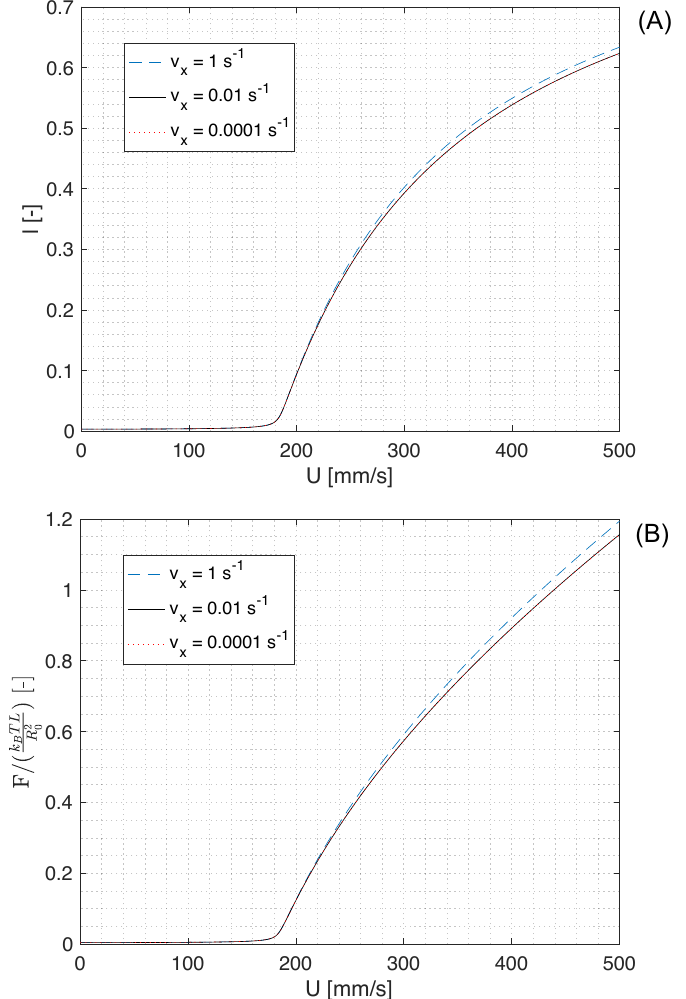
Figure 4. Polymer fractional elongation ( A ) and dimensionless recall force ( B ) as a function of shear velocity U , for a shear layer thickness h ≈ 0.2 µ m and different magnitudes of the radial velocity gradient v x